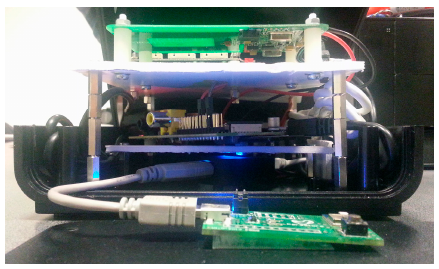
Figure 7. Hardware configuration of the first prototype.